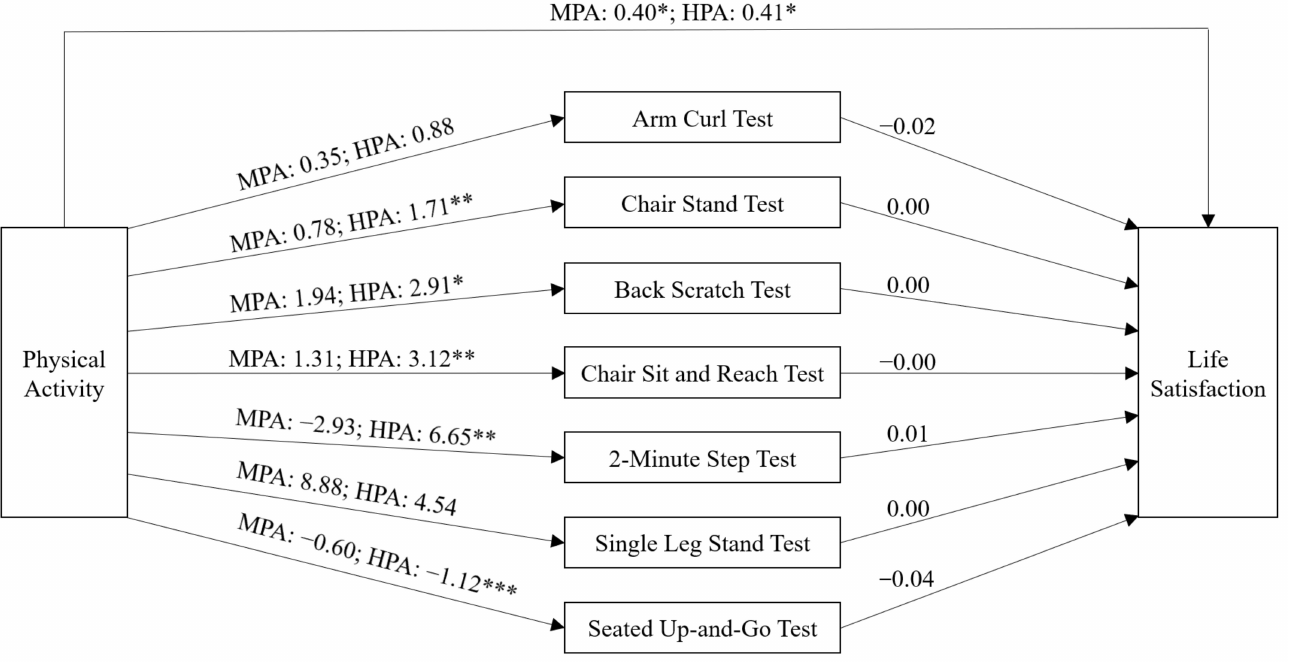
Figure 2. The pathways between physical activity, functional fitness, and life satisfaction. HPA: High Physical Activity; MPA: Moderate Physical Activity. * p < 0.05, ** p < 0.01, *** p <